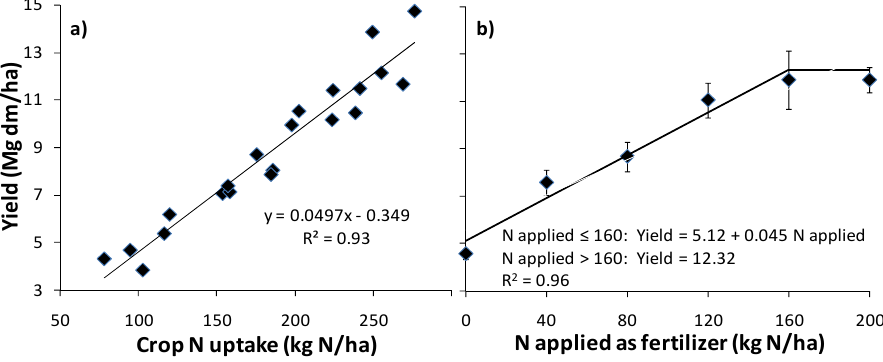
Figure 5. Maize yield vs. crop N uptake ( a ) and N applied as a fertilizer ( b ). In plot (a), symbols represent single plot values; in plot (b), they represent the treatment mean, and the standard error is presented as error bars. A linear model adjusted to the observed data is represented in plot (a); a linear-linear plateau model is represented in plot